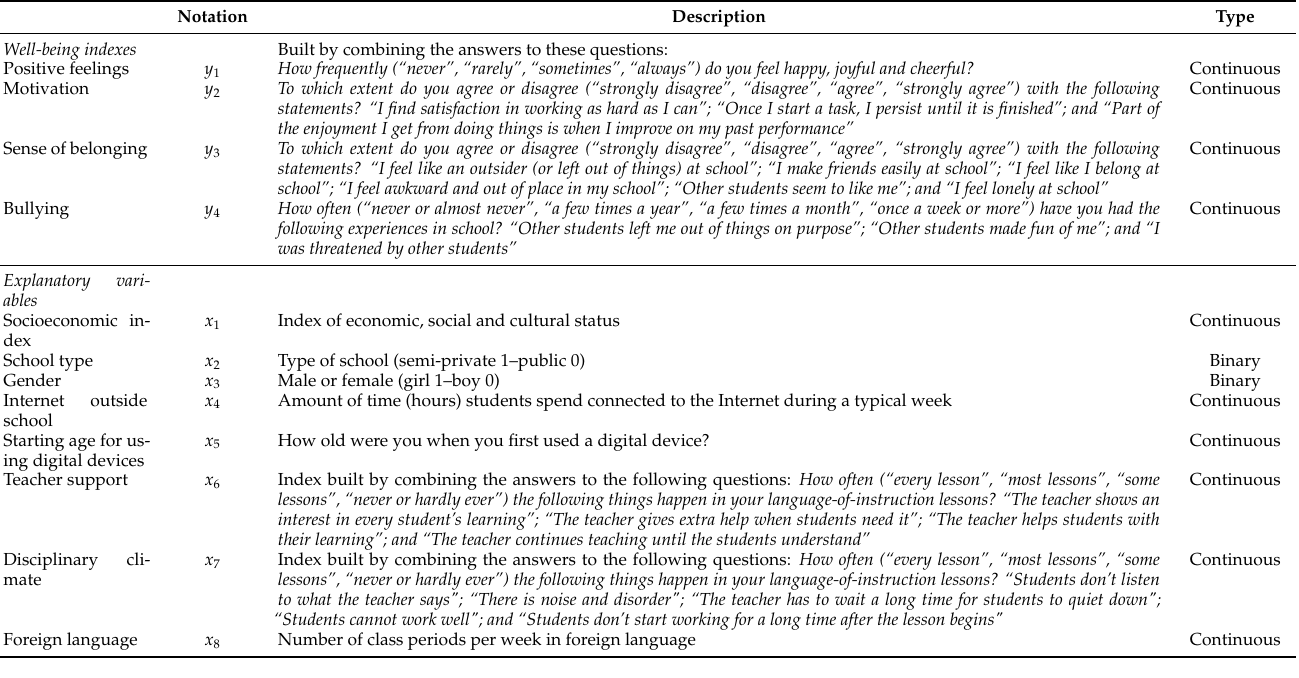
Table 1. Well-being indexes and explanatory variables.